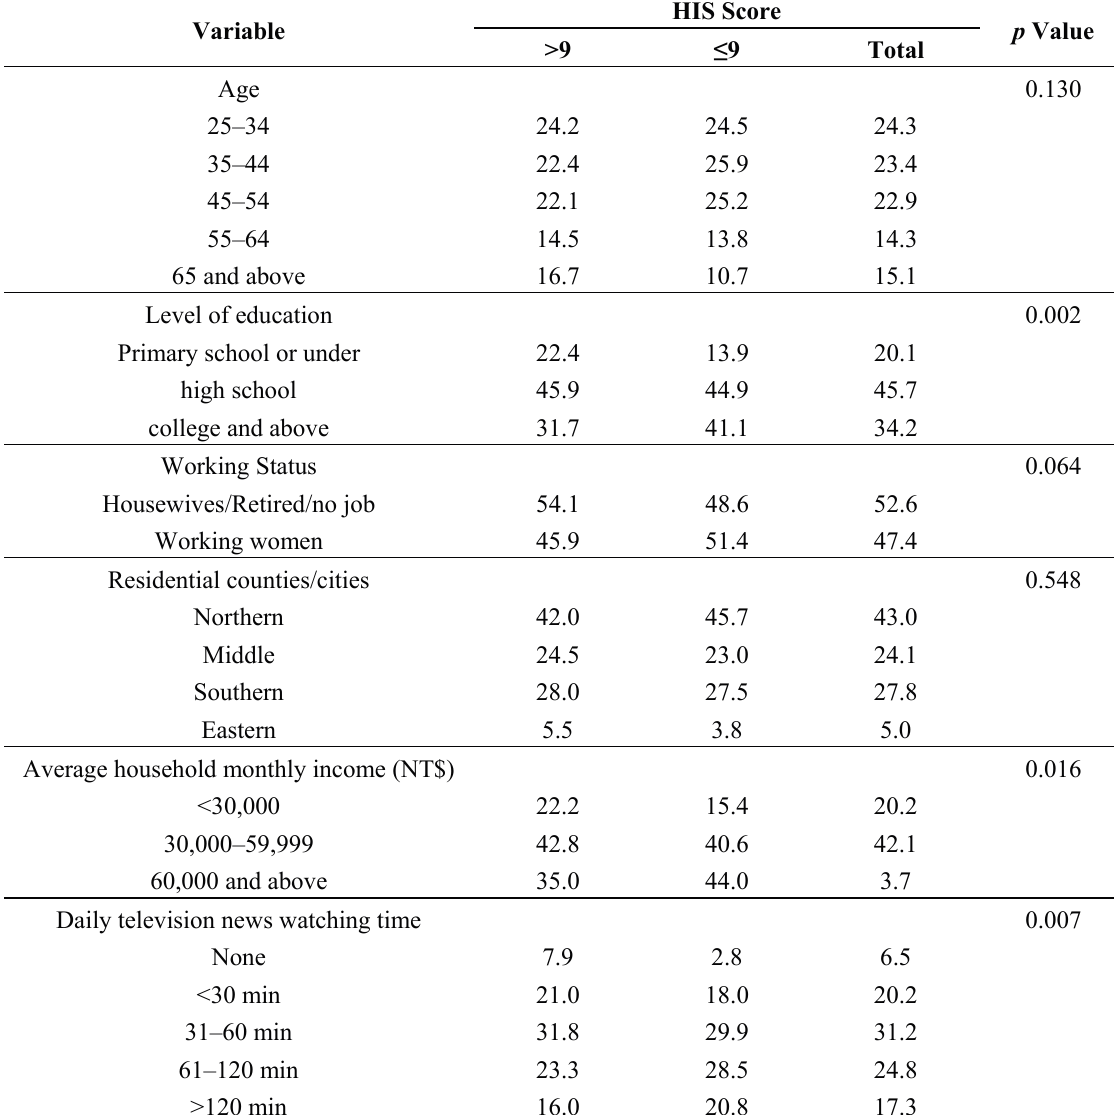
Table 1. Bivariate analysis of respondents’ agreement with publically promoted health messages (N =